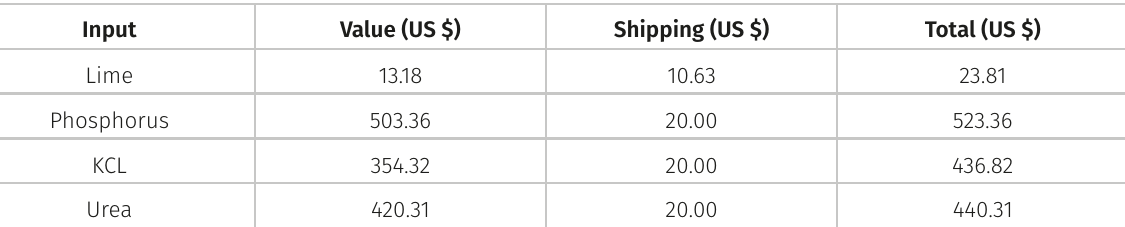
Table I. Acquisition costs and